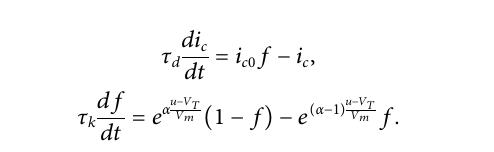
FIGURE 16 | Calculation of a memristor/solar cell model. (A) Current at forward and backward scan at different rates as indicated. The grey line is the total equilibrium dc current (B) Impedance spectrum at u (cid:2) 0 . 88 and (C) u (cid:2) 0 . 95. R b = 1; C m (cid:2) 10, i c 0 = 100, I ph (cid:2) − 5, V T (cid:2) 1, V m = 0.05, α (cid:2) 0, [ τ m , τ d , τ k , Q m ] .